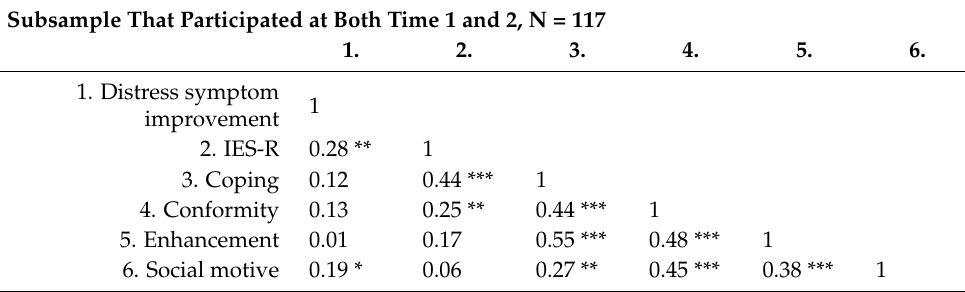
Table 2. Intercorrelations between the study variables. Subsample That Participated at Both Time 1 and 2, N = 117